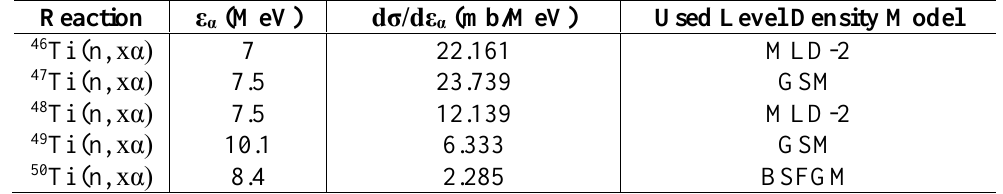
) for 46-50 Ti (n, xα) reactions at the 14.1 incident neutron α